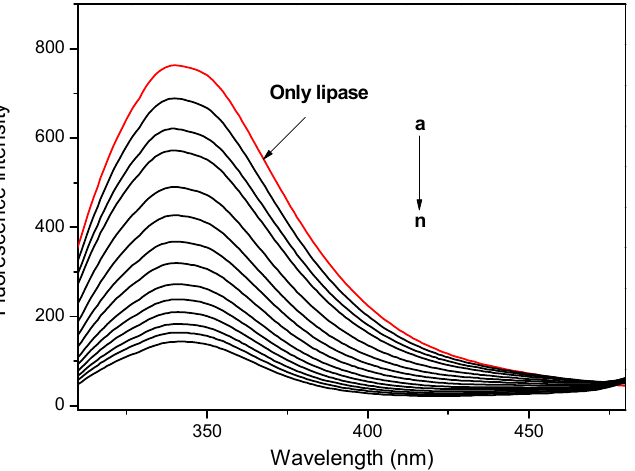
Figure 5. Emission spectra of lipase (0.5 mg/mL) in the presence of various amount of thioether